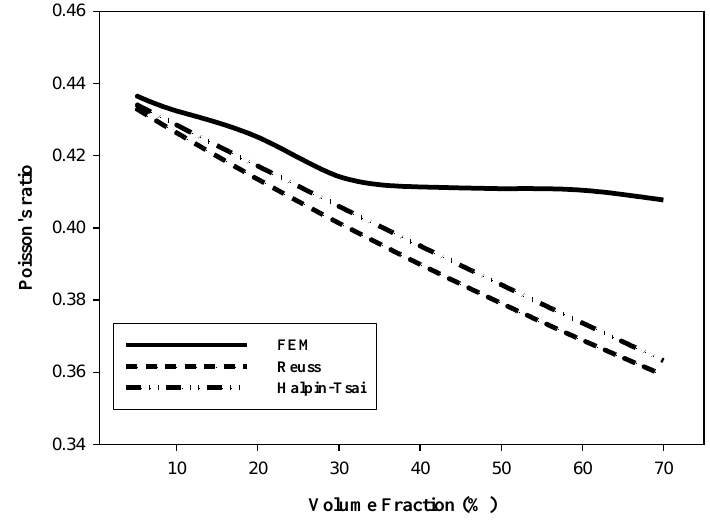
Figure 7. Poisson’s ratio predictions as a function of AP VF.